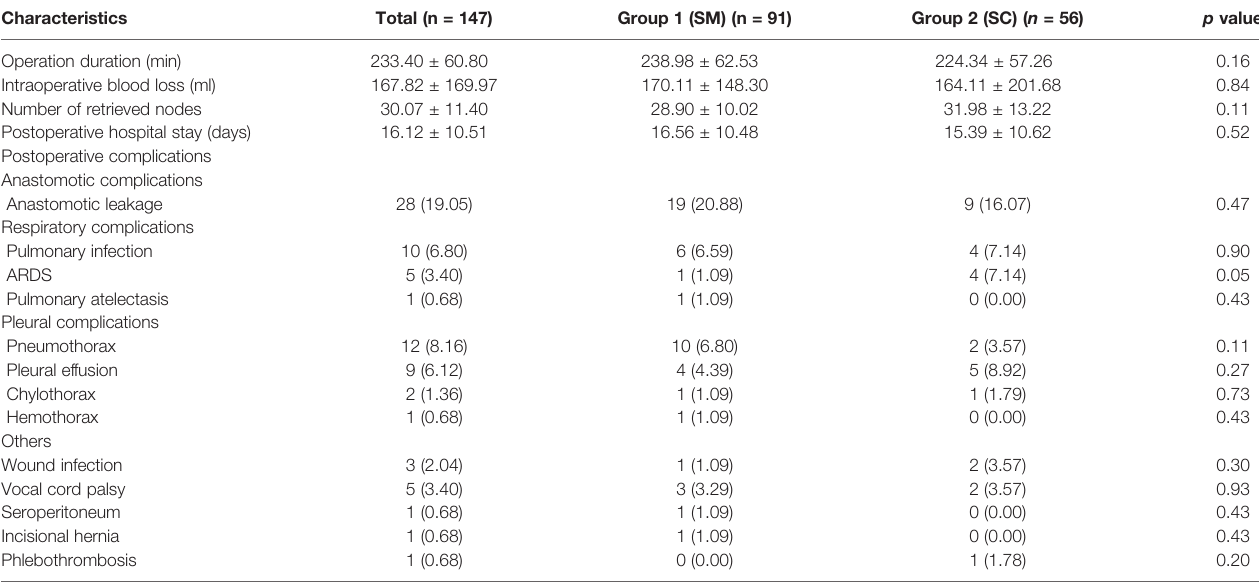
TABLE 2 | Intraoperative data and postoperative complications after PSM.